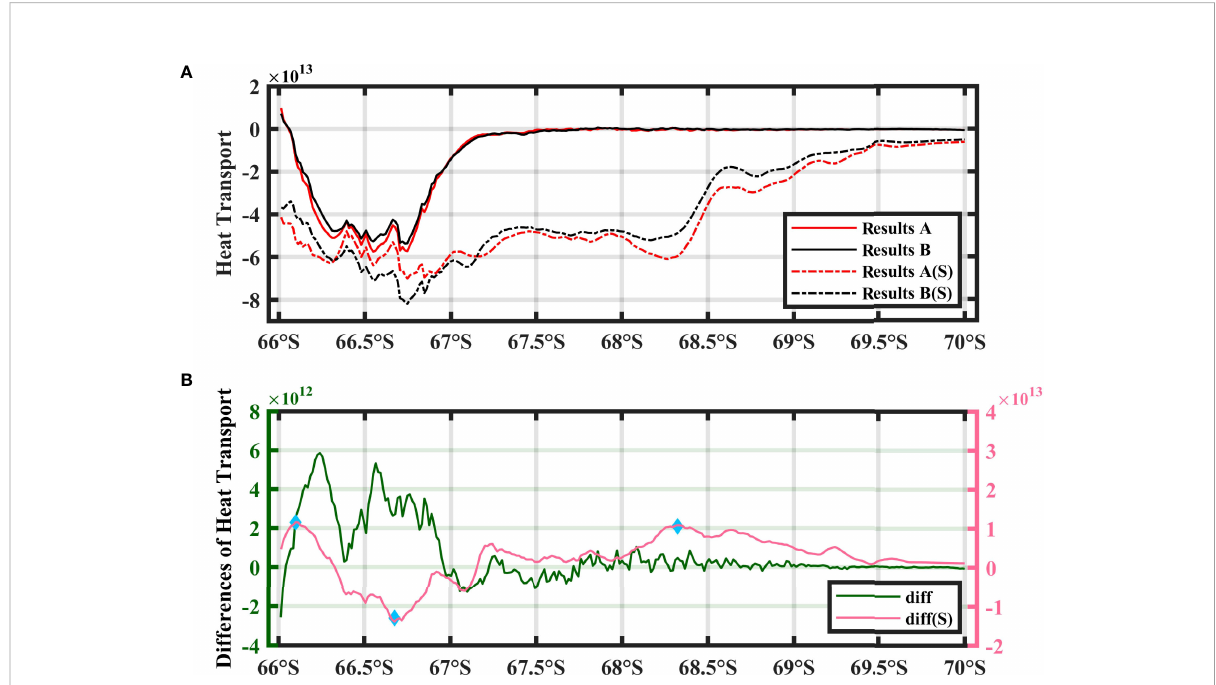
for the heat transport calculated by only using the southward velocity. (B) same as (A) , but for the differences between Result A and Result B (B minus A). The three blue diamond marks denote the three peaks at the latitudes of 66.1°S, 66.7°S and 68.3°S,